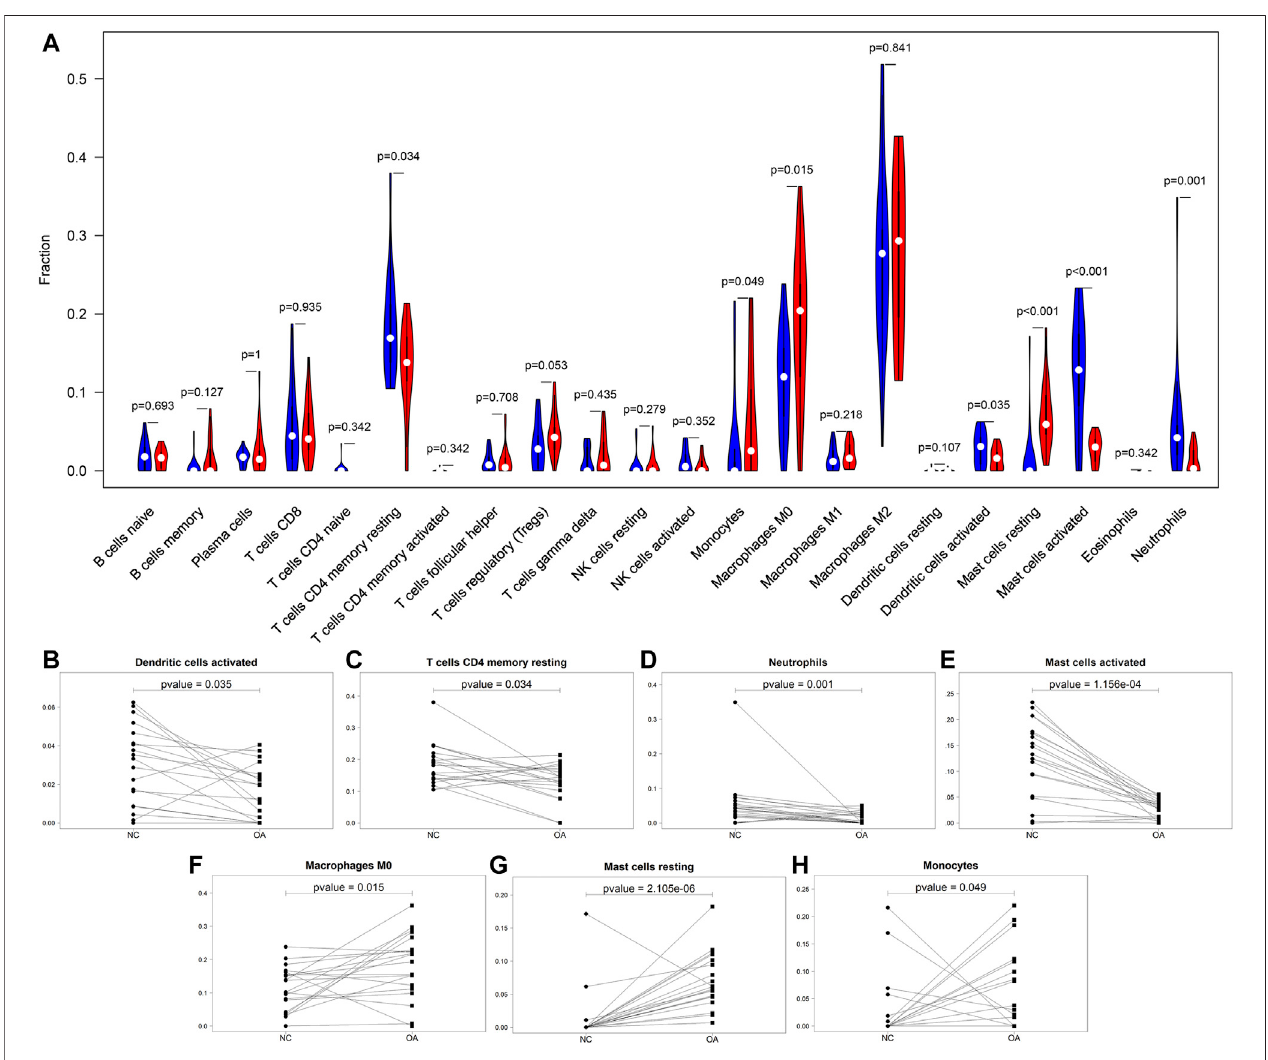
FIGURE 4 | Comparisons of immune in fi ltration between OA and healthy synovial tissues. (A) Violin plots of the in fi ltration levels of immune cells in OA (red) and healthy(blue)synovialtissuespecimens.Scatterplotsforthesigni fi cantdifferencesinin fi ltrationlevelsof (B) dendriticcellsactivated, (C) TcellsCD4memoryresting, (D) neutrophils, (E) mast cells activated, (F) macrophages M0, (G) mast cells resting and (H) monocytes in OA and healthy synovial